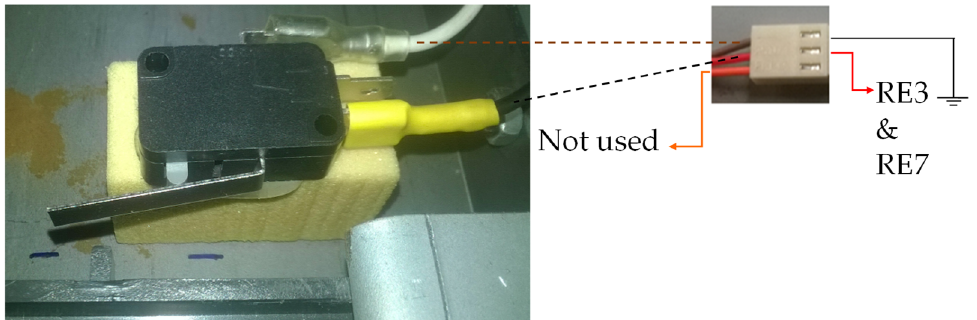
Figure 18. Waste bin sensor.